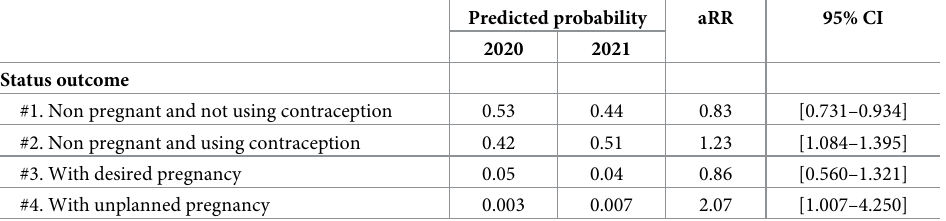
Multinomial model adjusted for age, education, parity, marital status, household size, socioeconomic status, area (urban vs. rural) and location of the household, with robust variance